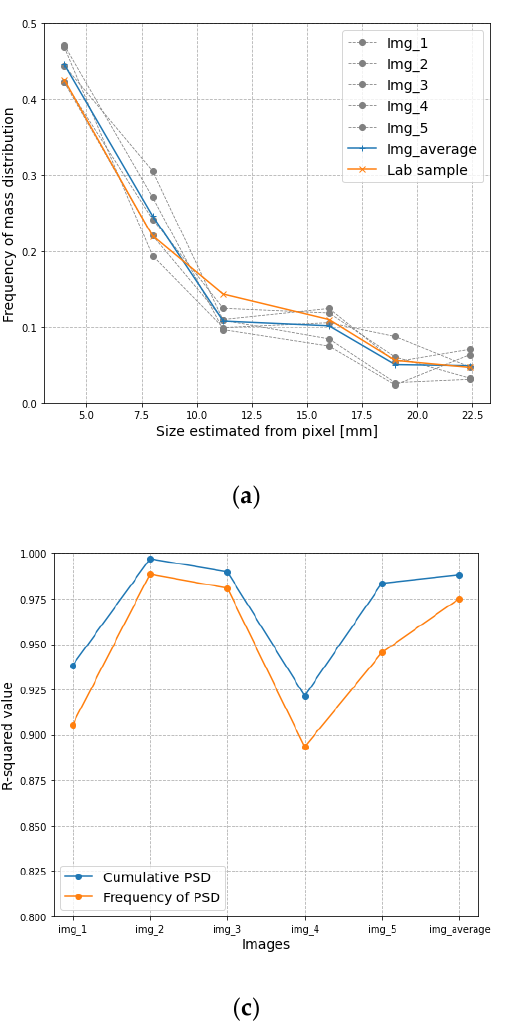
Figure 12. The results of the estimated mass distribution compared with lab sampling: ( a ) frequency of the size distribution;